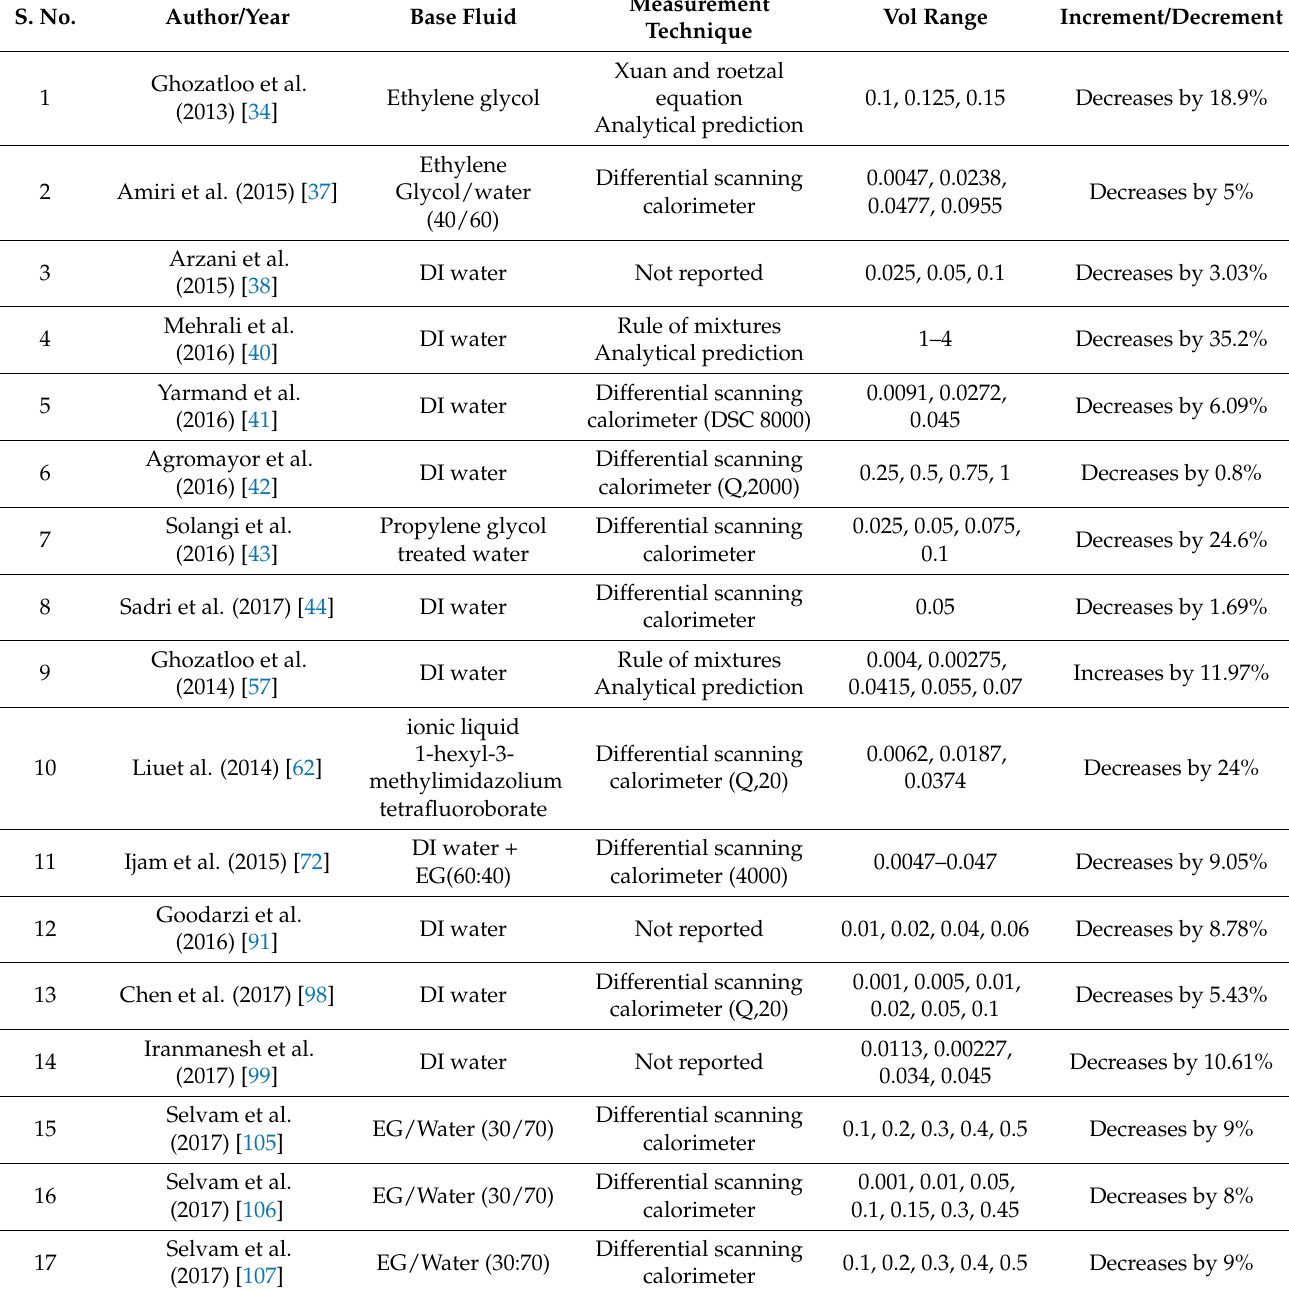
Table 10. Summary of published literature on specific heat capacity of graphene-based